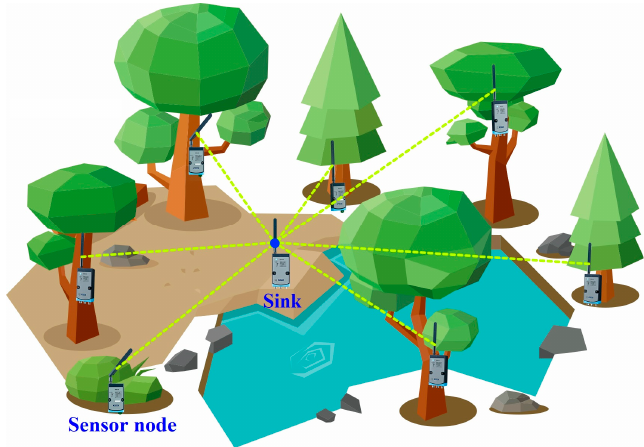
Figure 1. Schematic diagram of